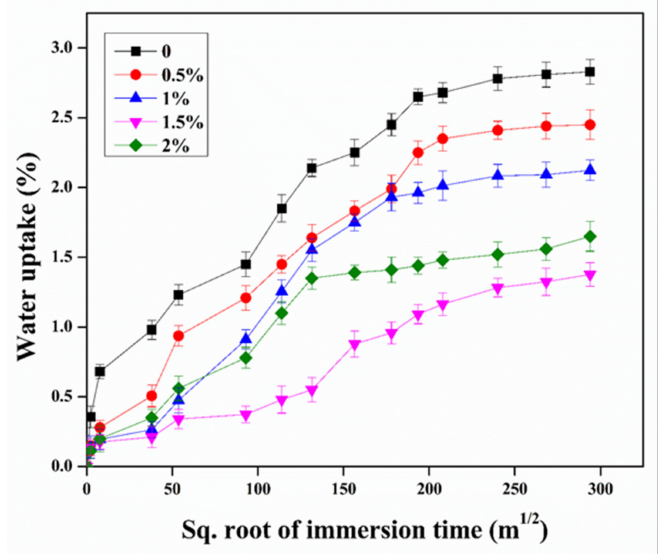
Figure 12. The water uptake versus square root of immersion time of epoxy/CNT